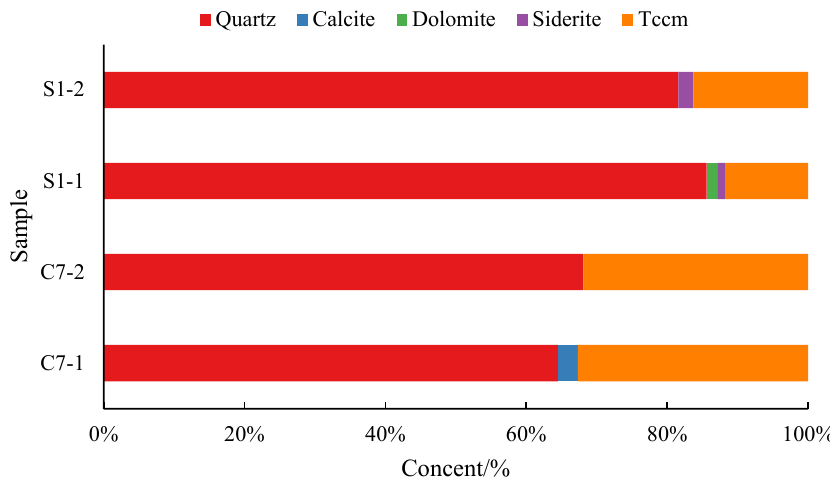
Figure 2. Rock mineral analysis of C7 and S1 shales.